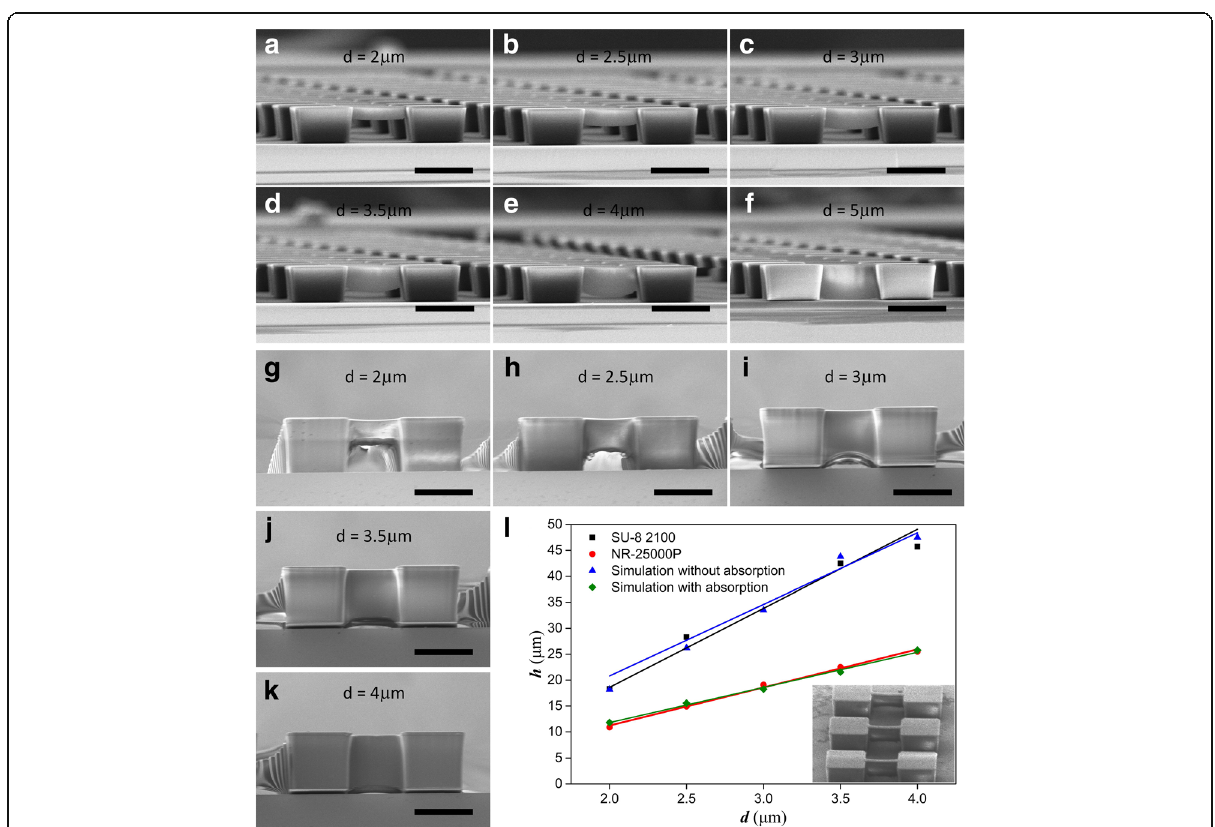
Fig. 4 The suspended photoresist beams resulted from one-step diffraction lithography with different line width d using the mask pattern in Fig. 3b. NR26-25000P photoresist beams under a d = 2 μ m, b 2.5 μ m, c 3 μ m, d 3.5 μ m, e 4 μ m, and f 5 μ m; SU-8 2100 photoresist beams under g d = 2 μ m, h 2.5 μ m, i 3 μ m, j 3.5 μ m, and k 4 μ m; l the functions of exposure thickness vs. line width in simulation without absorption, NR26- 25000P, and SU-8 2100 and simulations with absorption coefficient α = 0.0374 μ m − 1 , where the inset shows the tilted view of SU-8 suspended beams. The thickness of the beams increases with the line width of the mask pattern. The scale bars are 50 μ